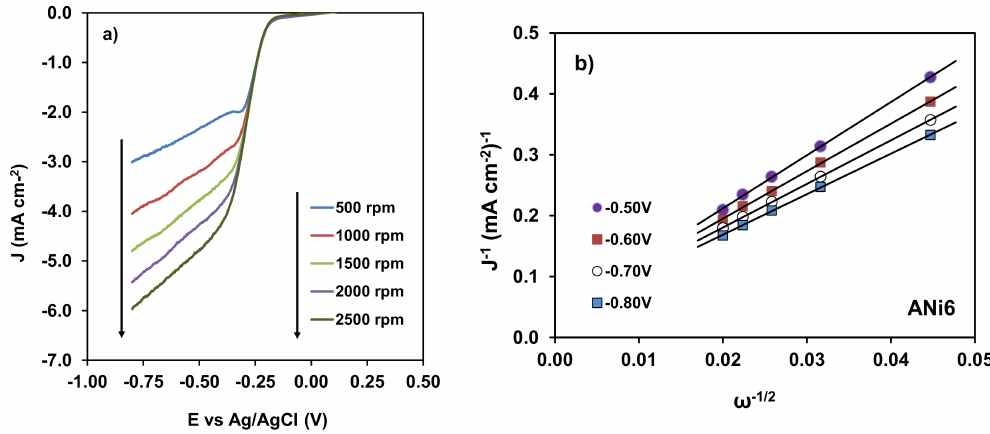
Figure 9. ( a ) LSV for ANi6 at different RDE rotating speed. ( b ) Koutecky-Levich fits at different potentials: from − 0.5 to − 0.8 V.